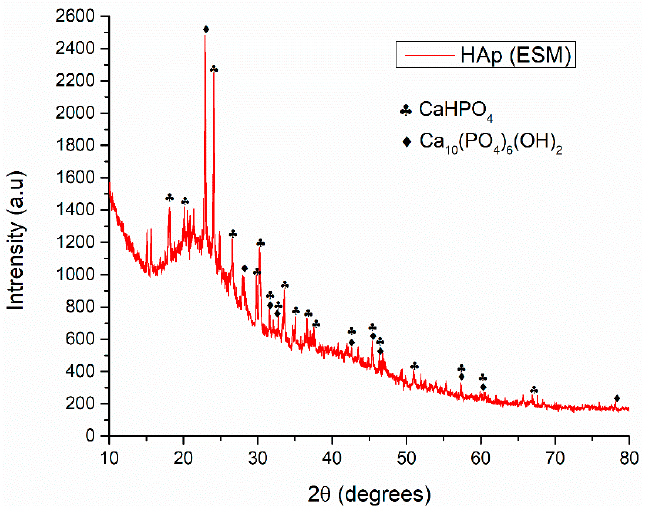
Figure 1. XRD analysis of microwave synthesized hydroxyapatite on ESM.